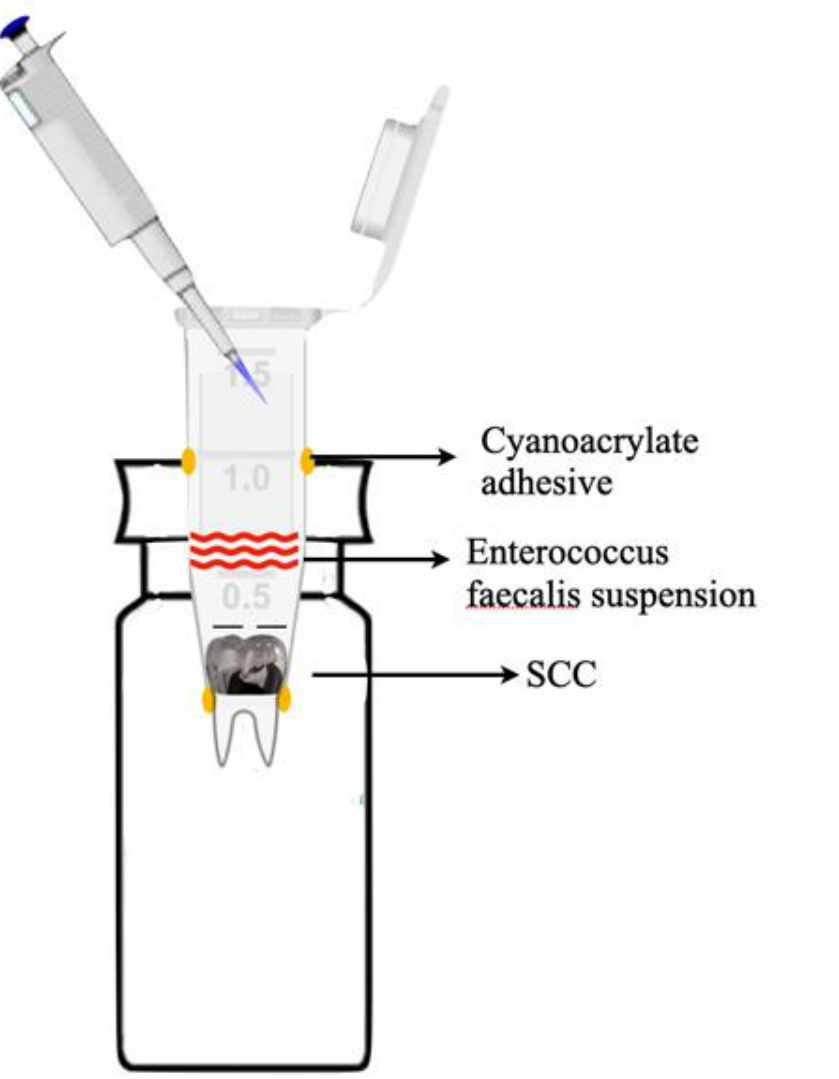
Figure 1. Experimental model. Each tooth was placed in a 1.5 mL Eppendorf plastic tube and then inserted into a 20 mL disposable glass scintillation vial through the opening of the rubber cap so that the plastic tube fitted tightly inside the glass vial. The junctions between the teeth, the Eppendorf tube, and the rubber cap were sealed with a cyanoacrylate adhesive. The system was then sterilized overnight using ethylene oxide